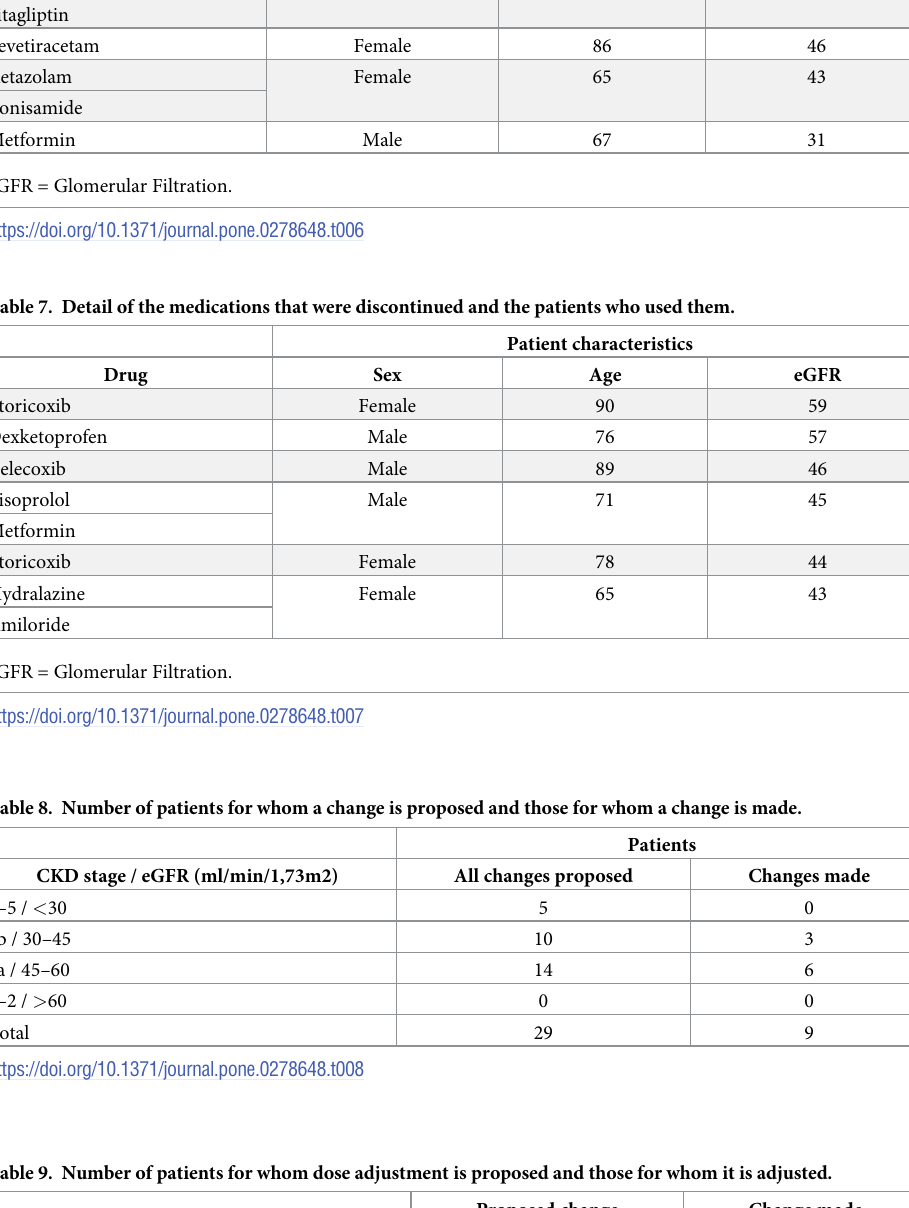
Table 6. Detail of the medications with dose adjustment and the patients who used them.